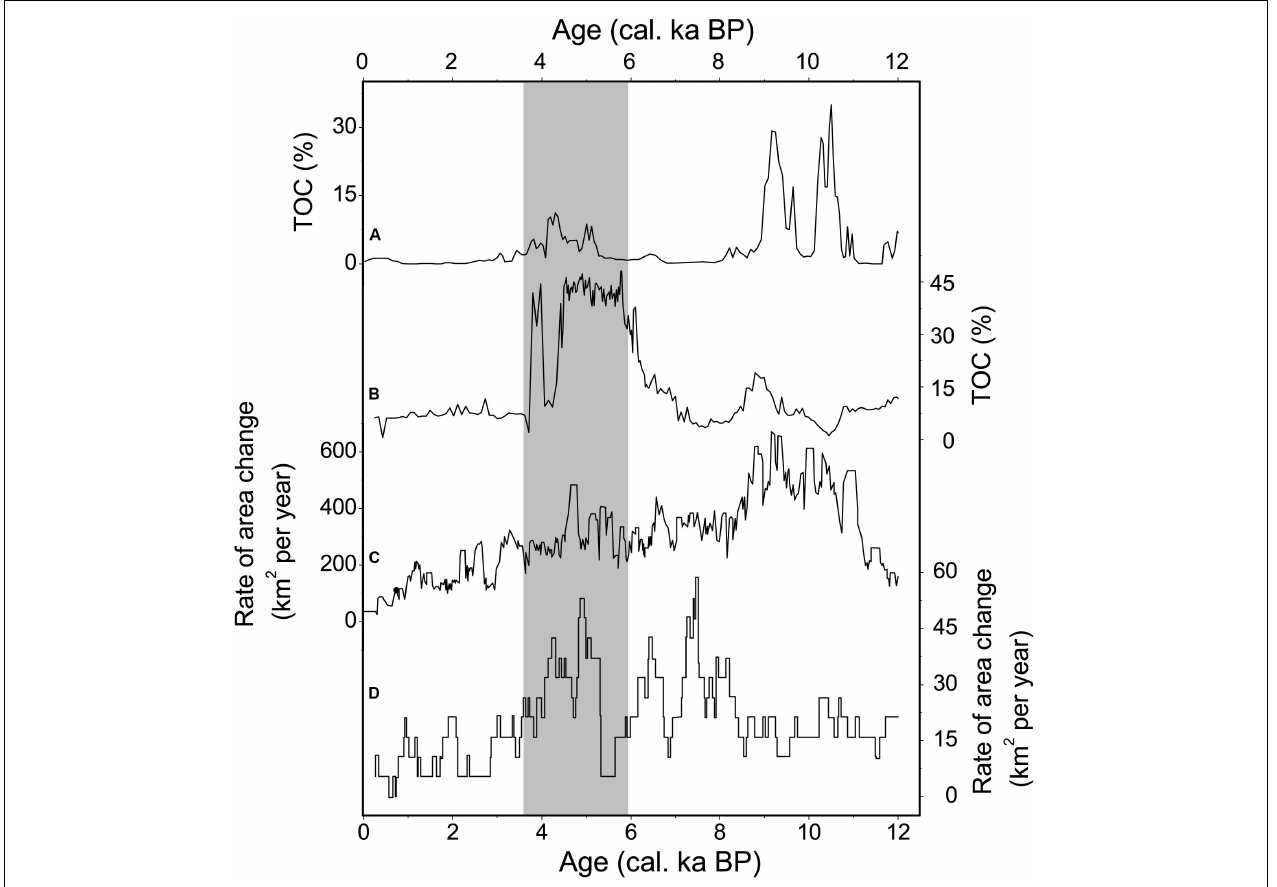
FIGURE 7 | Carbon accumulations in MDW and DH with the area of change in global peatlands during the Holocene. Panel (A,B) are the carbon accumulations in MDW and DH, respectively. Panel (C,D) are the rates of area change, respectively, for the northern peatlands and the tropical peatlands (Yu et al., 2010).